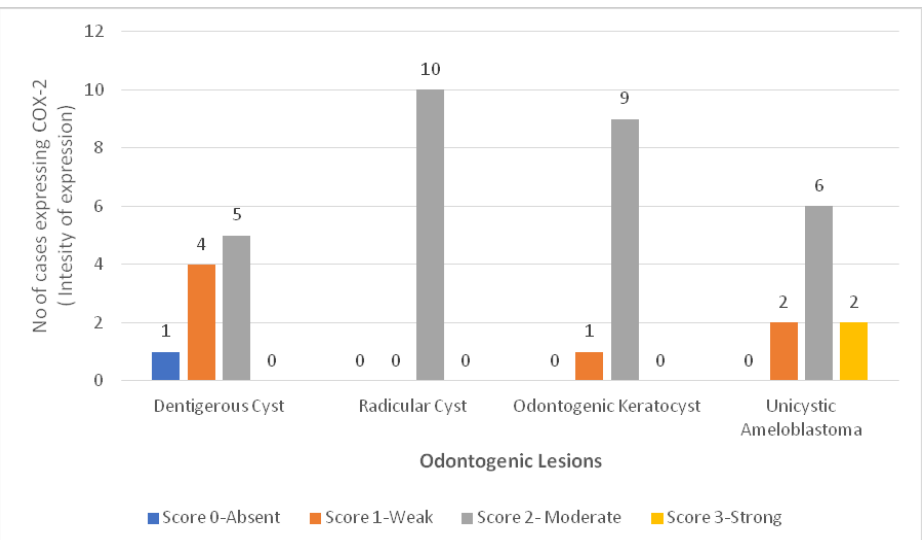
Fig 3. Comparison of the intensity of the expression of COX-2 by the odontogenic epithelial cells in different odontogenic